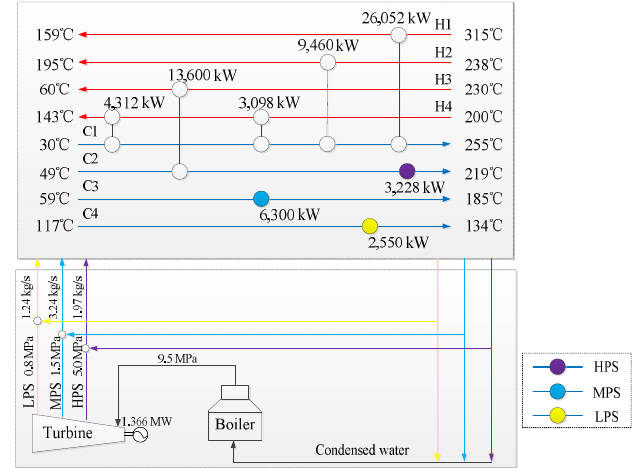
Figure 4. Structure with minimum TAC of Scenario 3